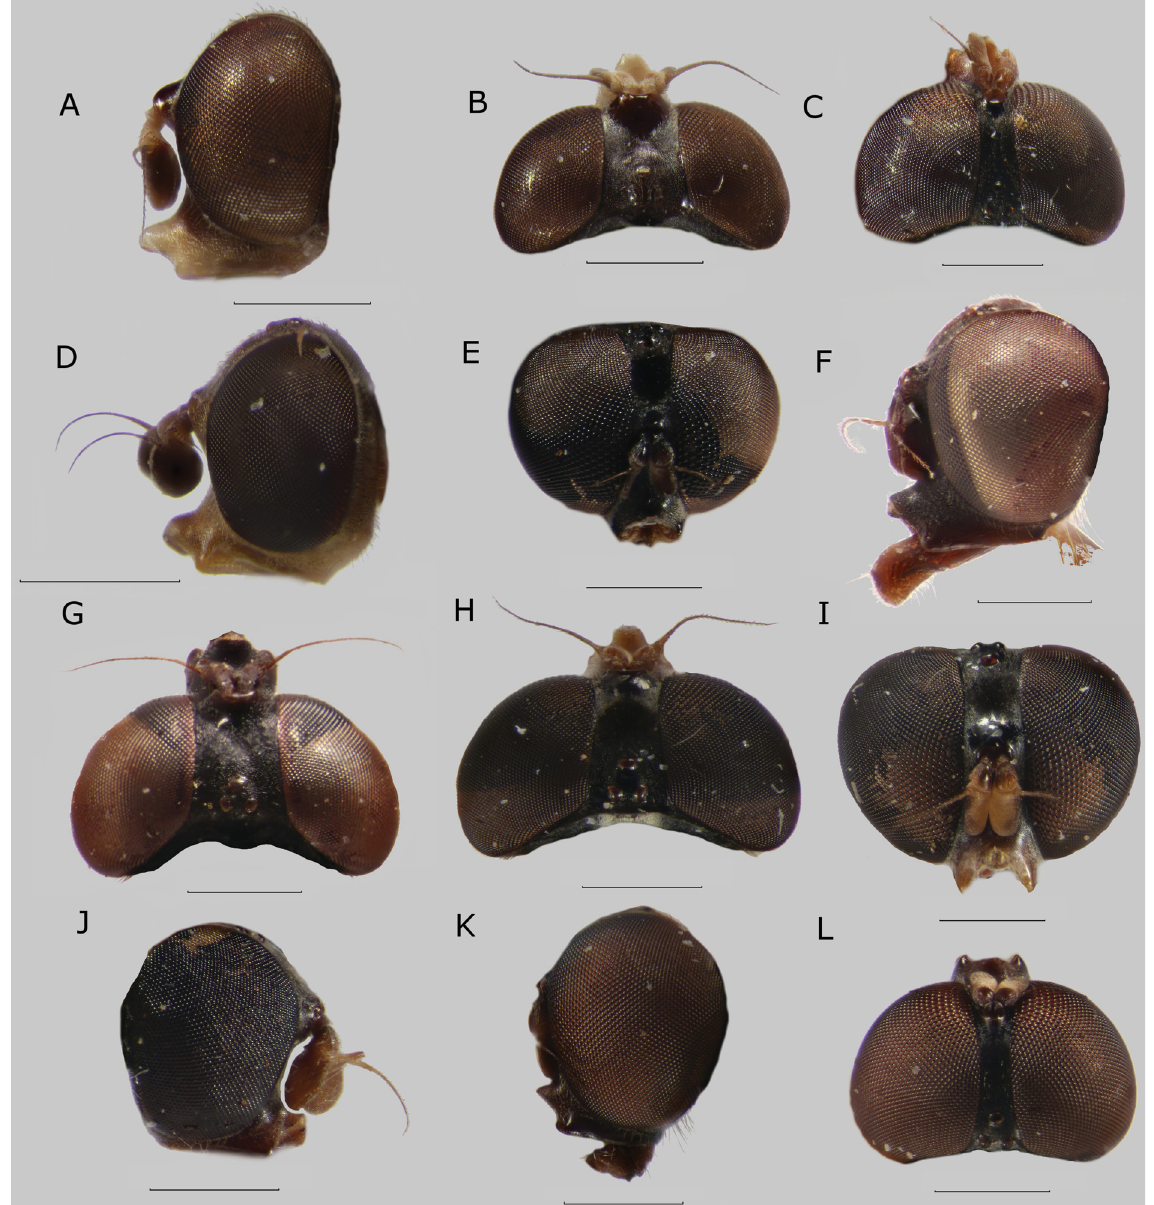
Fig. 21. Head, lateral view (A, D, F, J–K), dorsal view (B, C , G–H, L), frontal view (E, I). A–B . Sphegina (Asiosphegina) albolobata sp. nov., holotype, ♂ , Vietnam. C . S. (A.) amplistylus sp. nov., holotype, ♂ , Philippines. D . S. (A.) apicalis Shiraki, 1930, ♀ , Taiwan. E . S. ( A.) bi fi da sp. nov., holotype, ♂ , Sabah, Malaysia. F–G . S. (A.) bracon sp. nov., paratype, ♂ , Vietnam. H–I . S. ( A. ) bispinosa Brunetti, 1915, ♂ , Nepal. J . S. (A.) brevipilis sp. nov., holotype, ♂ , China. K–L . S. ( A.) collicola sp. nov., paratype, ♂ , Malaysia. Scale bars = 0.5